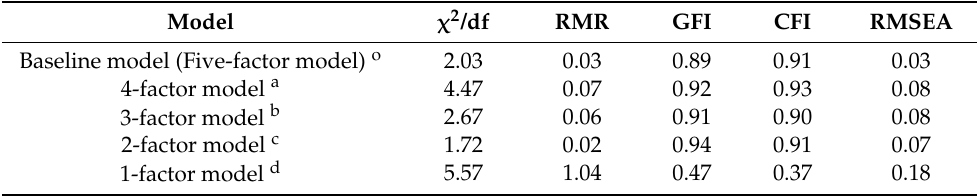
Table 2. Results of confirmatory factor analysis (N = 354). Model χ 2 /df RMR GFI CFI RMSEA Baseline model (Five-factor model) o